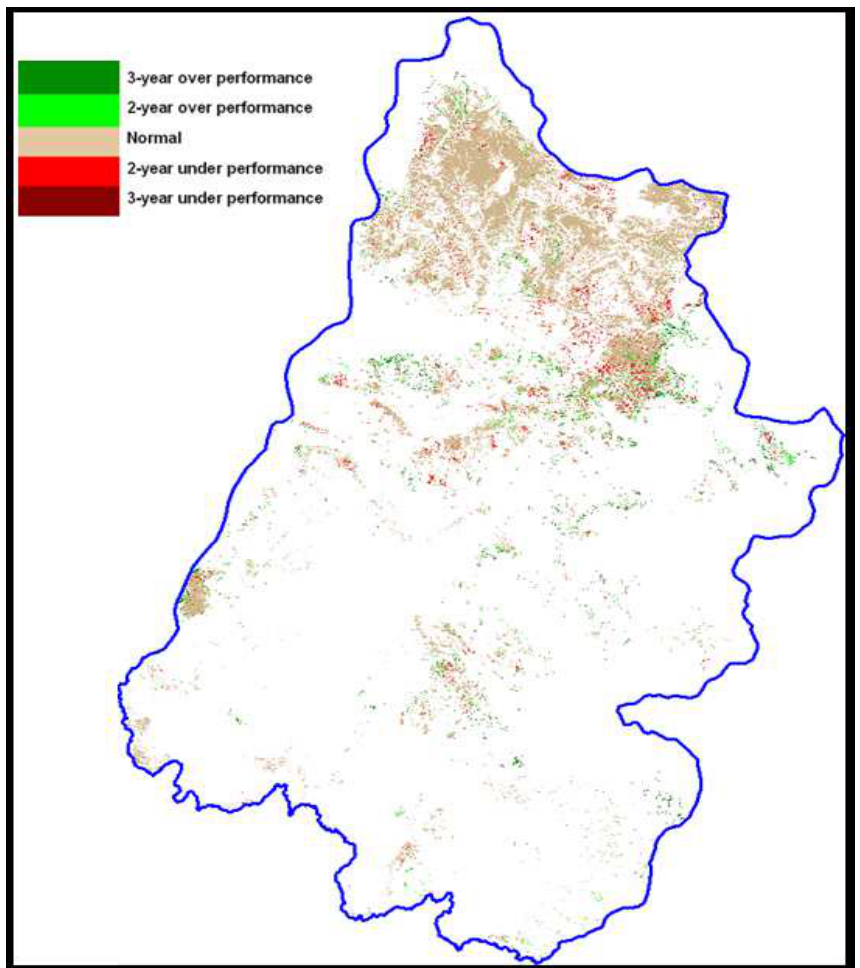
Figure 6. 3-year (2005–2007) ecosystem performance anomaly map for big sagebrush in the